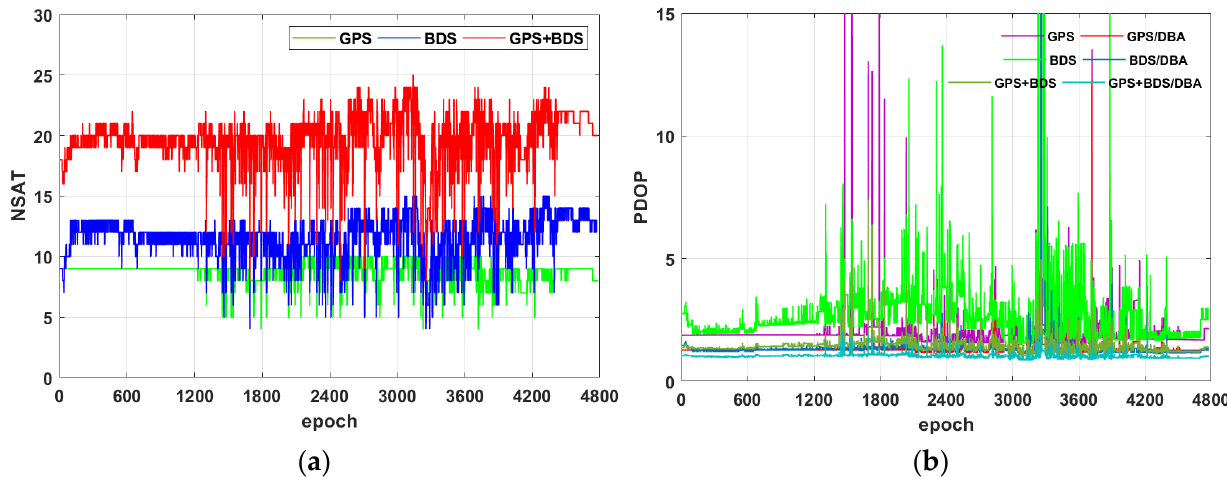
Figure 13. Observation values of kinematic vehicle experiment in the open urban environment: ( a ) the number of GNSS visible satellites; ( b ) the sequence of PDOP